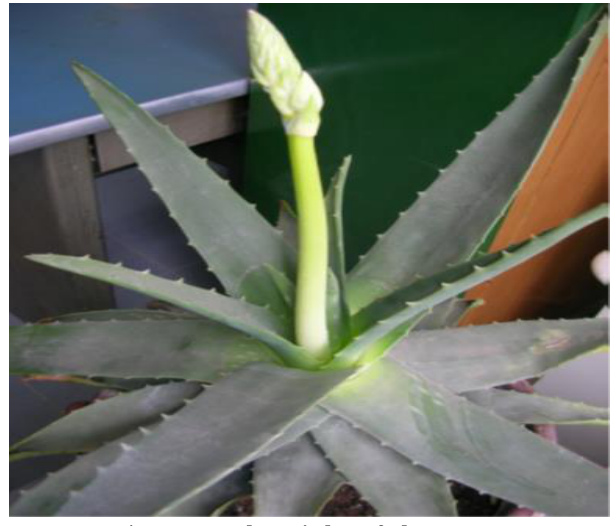
Fig. 1. External morphology of Aloe vera.